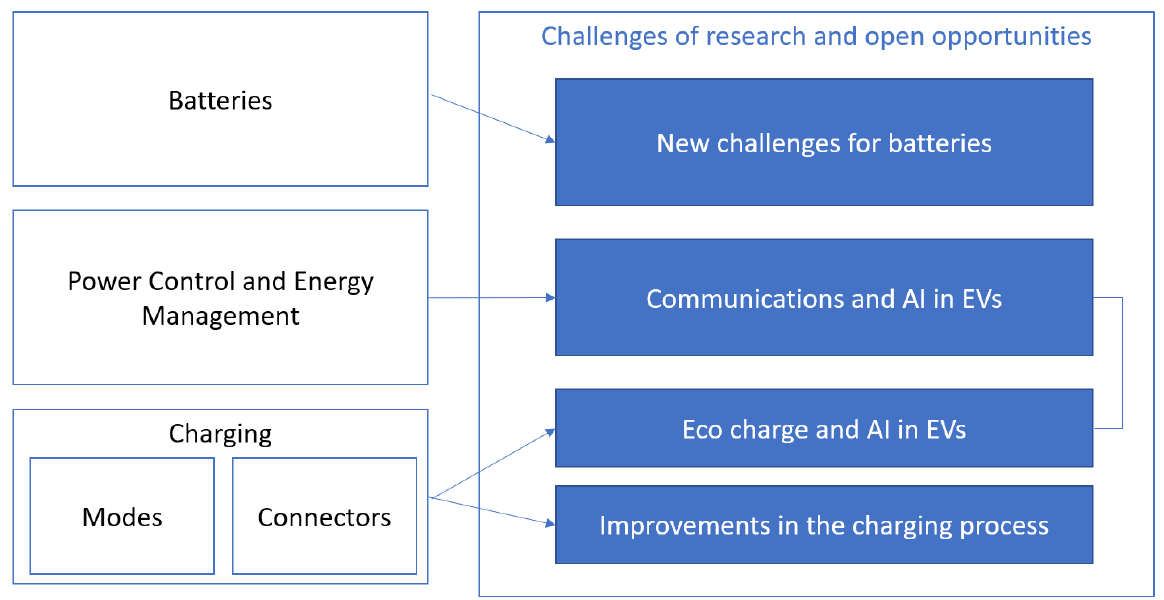
Figure 2. Topics included in our